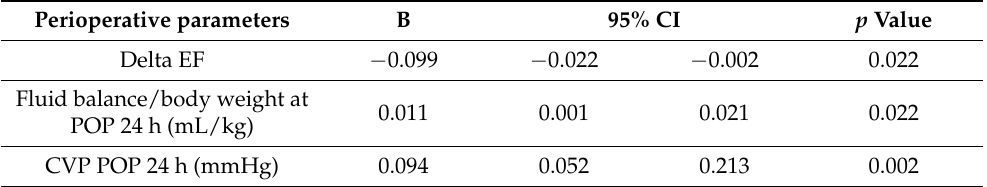
Table 4. Linear regression of the delta VTI ratio (postop–preop retrograde/anterograde VTI ratio). Perioperative